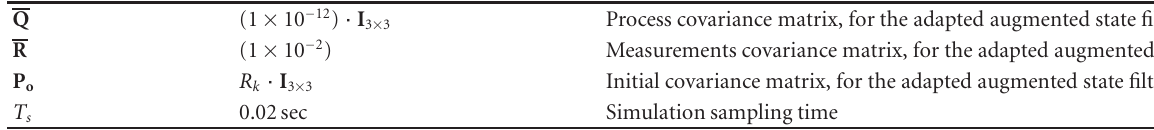
Table 4: Attitude, augmented state filter